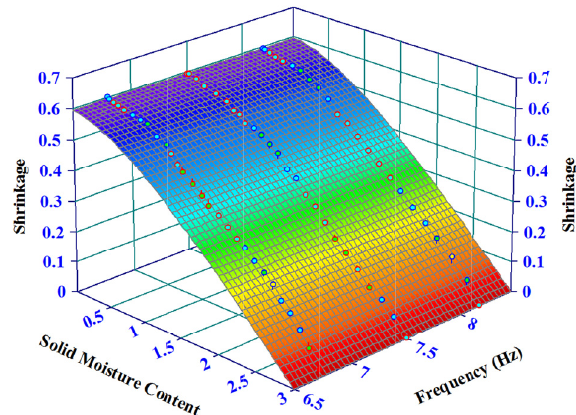
Fig. 7. Shrinkage variation versus drying time of hawthorn at drying air temperatures with and without vibration (drying airflow rate= 26 m 3 /h)